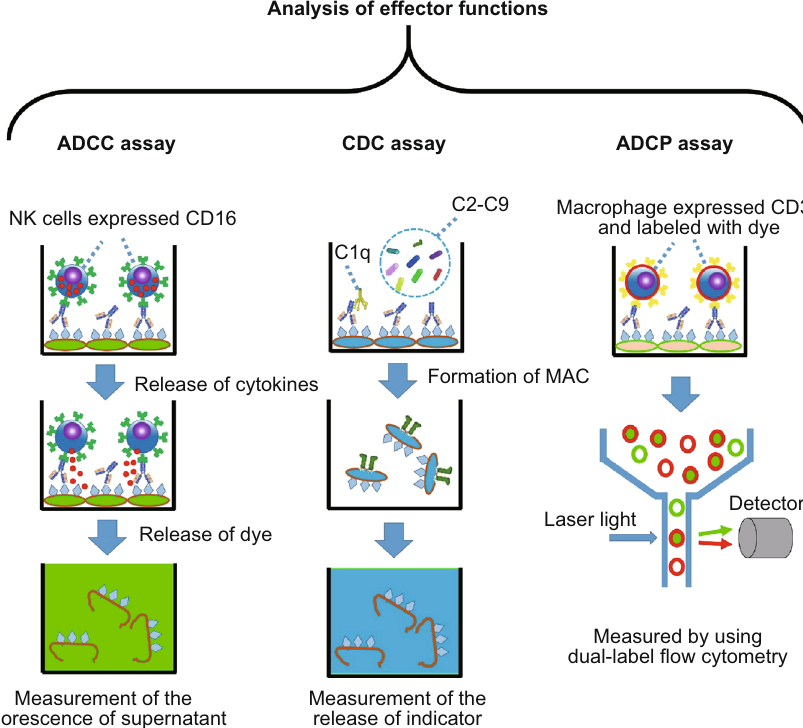
Figure 3. Analysis of effector functions. For the ADCC assay (left panel), target cells are labeled with an indicator (such as calcein) and opsonized by using the test antibody at the indicated fi nal concentration, effector cells (puri fi ed NK cells or peripheral blood mononuclear cells) are added in an appropriate ratio to target cells, and the fi nal fl uorescence intensity of the supernatant is measured. The procedure of the CDC assay (middle panel) is similar to the ADCC assay, except for the use of a complement to replace the effector cells. For the ADCP assay, target cells and the macrophage (differentiated by puri fi ed monocytes) were fi rst labeled with fl uorescent dyes and opsonized with the test antibody at indicated fi nal concentration, after which the fl uorescence